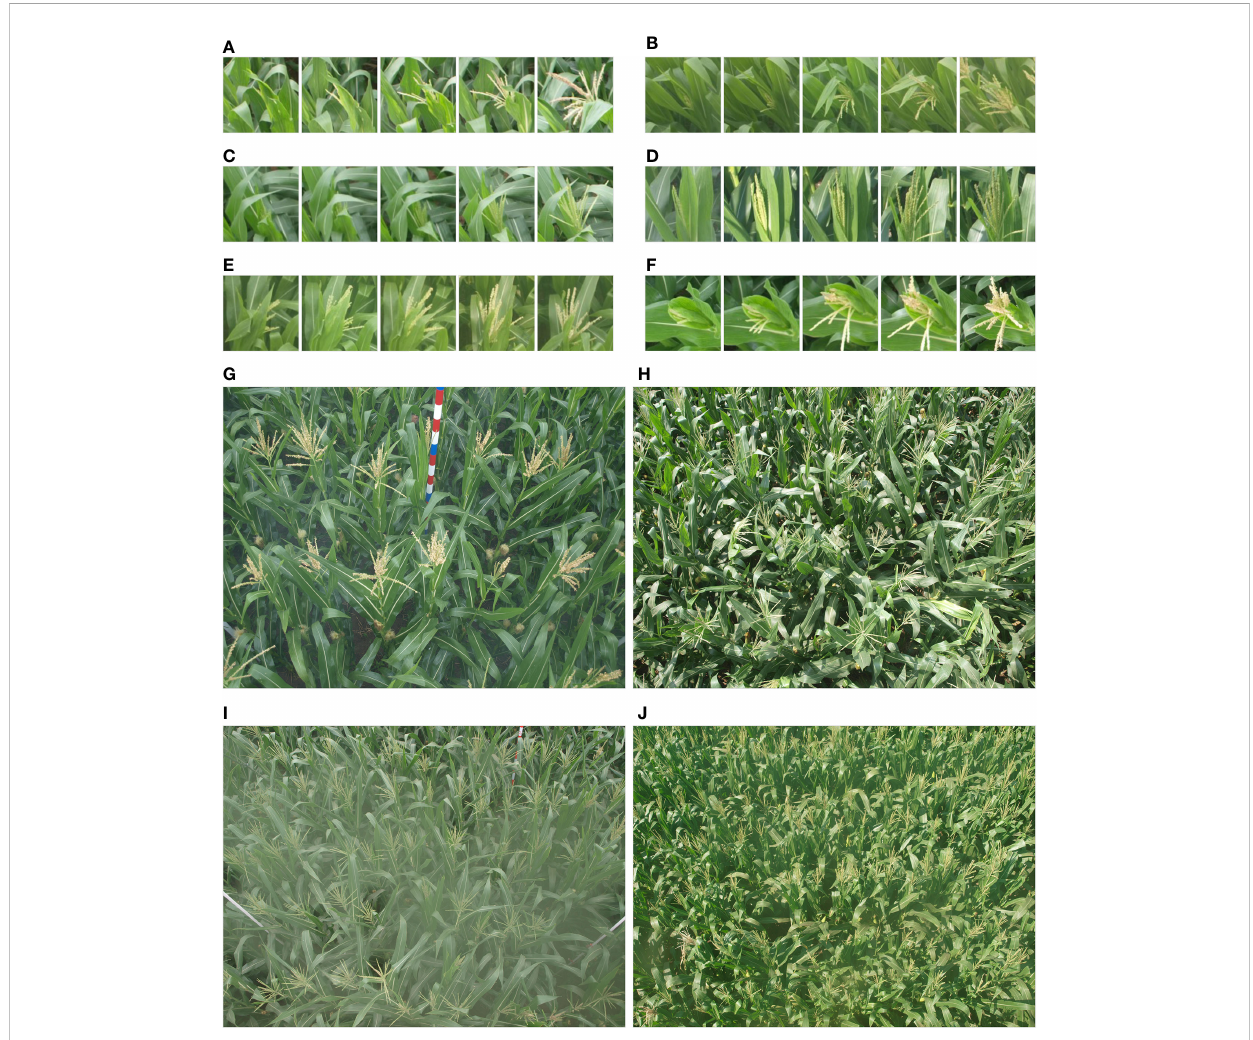
FIGURE 1 Example of fi eld imaging of maize tassels in the MrMT dataset. (A – F) present images of tassels from tasseling stage to fl owering stage in multiple time sequences; (G – J) are example images in different scenarios, respectively from Hebei2012, Shandong2011_1, Shandong2010_2, Henan2012, it can be observed that the growth environment of maize is complex and is challenging for automatic